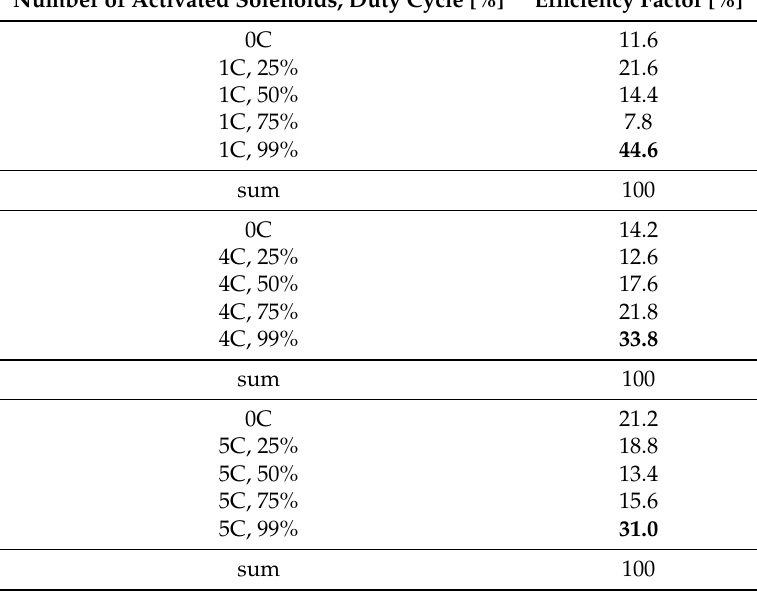
Table 6. Efficiency factors calculated for MFC4, depending on the number of solenoids and the value of duty cycle of a PWM signal.